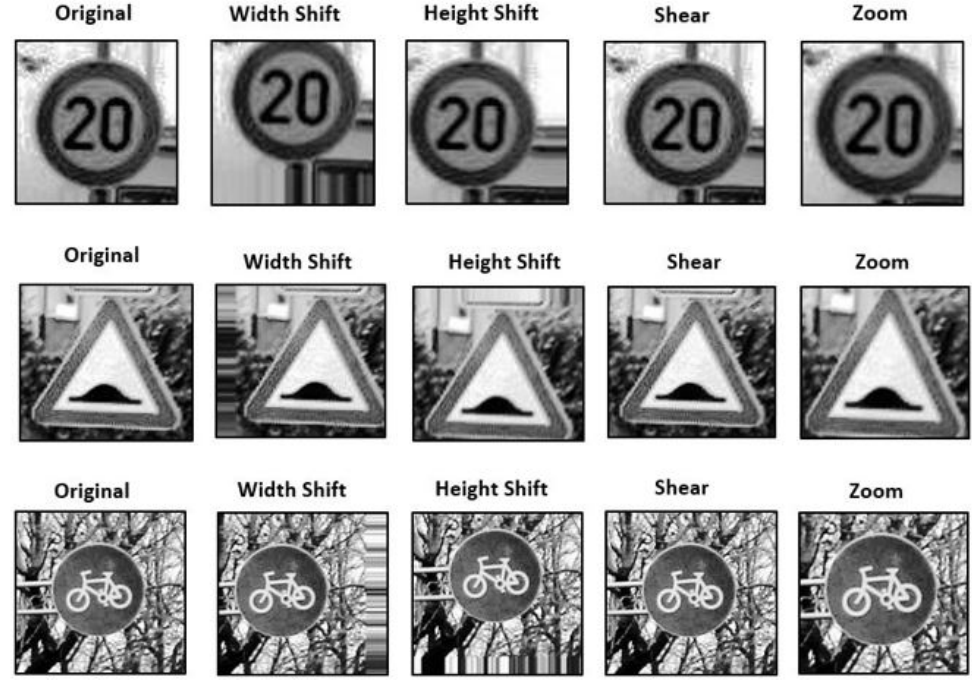
Figure 2. Sample output images of data augmentation techniques on GTSRB (top row ), BTRD ( middle row ), and TSRD ( bottom row ).